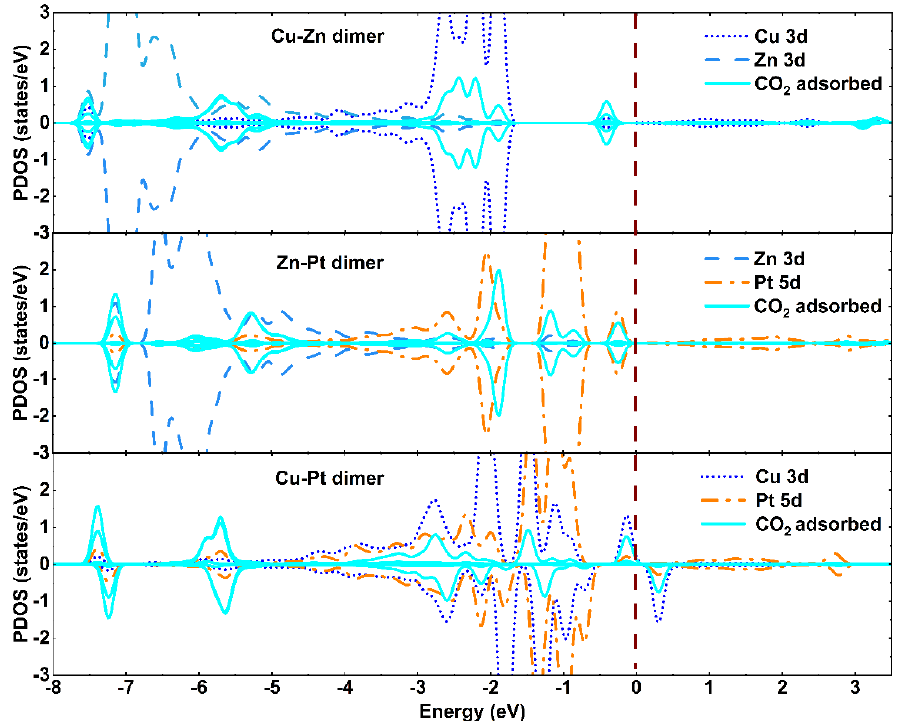
Figure 5. Partial density of states of the absorbed CO 2 on bimetal-embedded TiO 2 system (bimetallic dimers were Zn-Cu, Zn-Pt, and Cu-Pt). The Fermi level was set to zero and is marked with a grown dashed line. Table 2. Calculated results for a CO 2 molecule on an A-TiO 2 (101) surface during the adsorption process. d M-N and d O(1)-C are the bond lengths between metal M and metal N, and between the O (1) atom and the C atom, respectively, for chemical adsorption structure. E CO2ads stands for the adsorption energy of CO 2 adsorbed on TiO 2 (101) surface. ∆ Q is the charge transfer from bimetallic dimer-embedded TiO 2 to CO 2 molecule. M stands for the former metal atom, and N stands for the latter